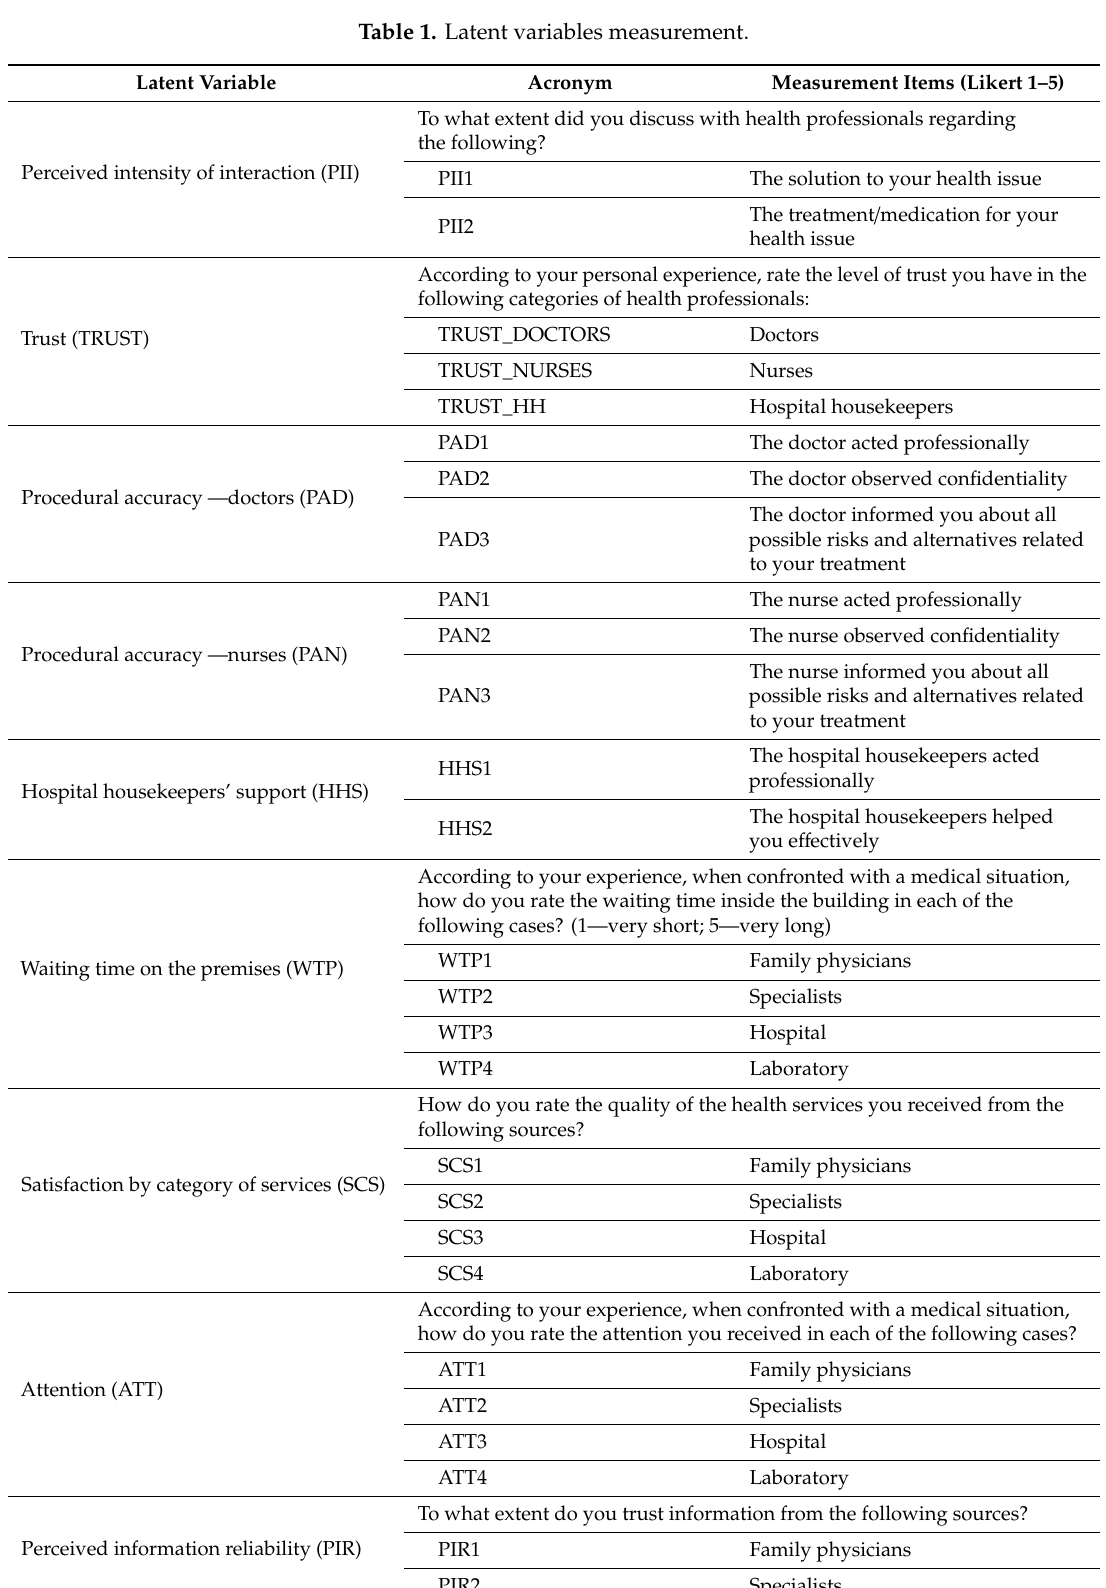
Table 1. Latent variables